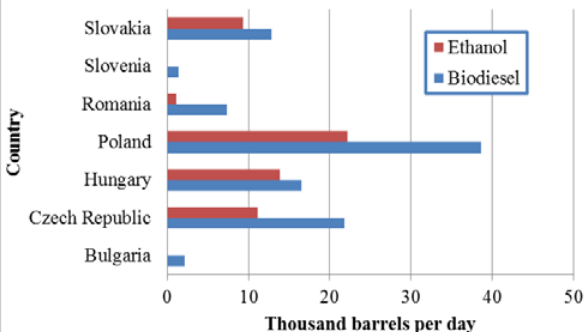
Fig. 3. Production of biodiesel and ethanol in CEE from 2005 to 2012 (Source: authors based on United States Energy Information